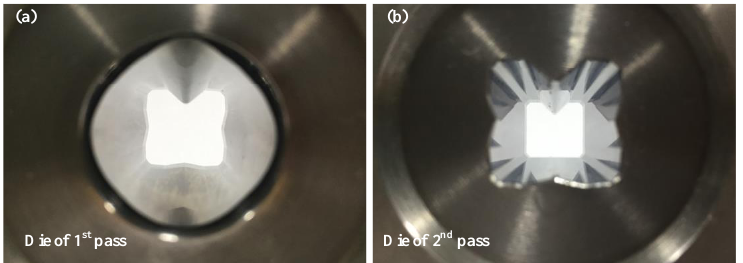
Figure 14. Drawing dies of the multi-pass shape drawing experiment for the cross-roller guide: ( a )